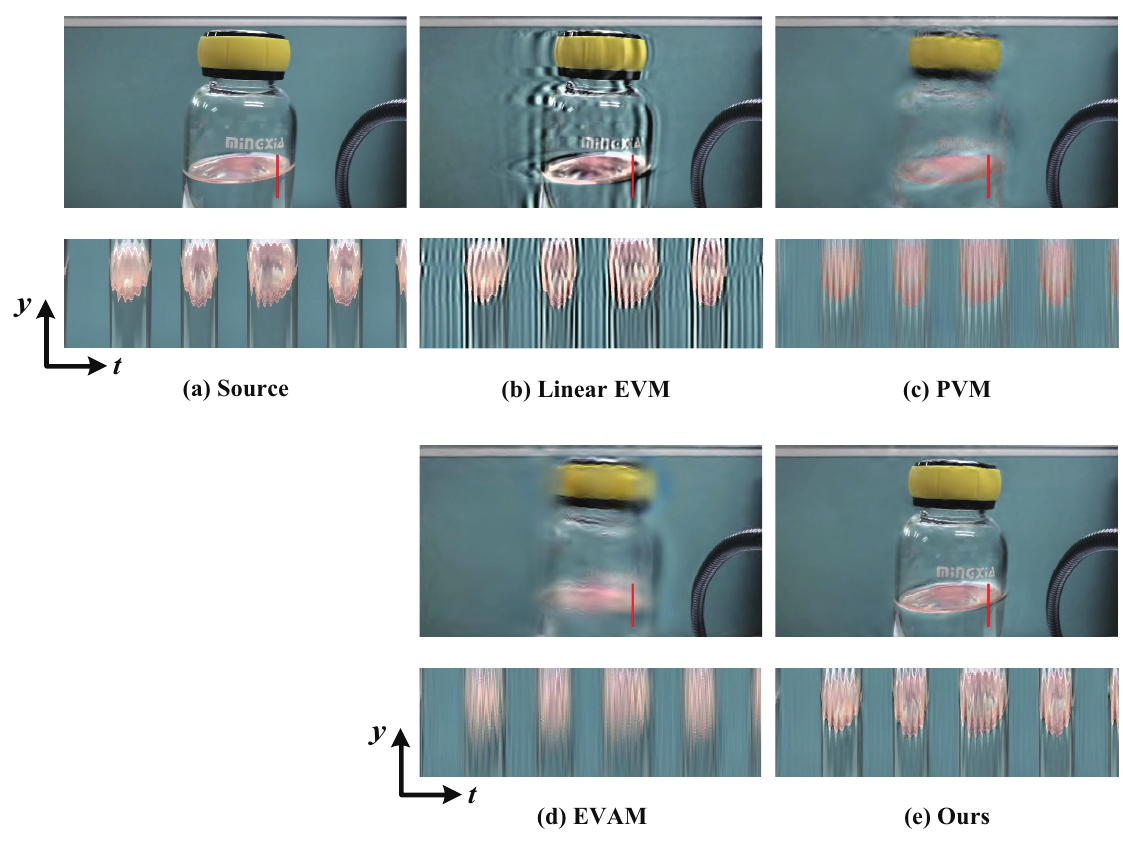
Figure 3. Comparison of the motion magnification results on water sequence against different approaches. For each approach, we show the spatio-temporal Y − T slice for the solid red line. ( a